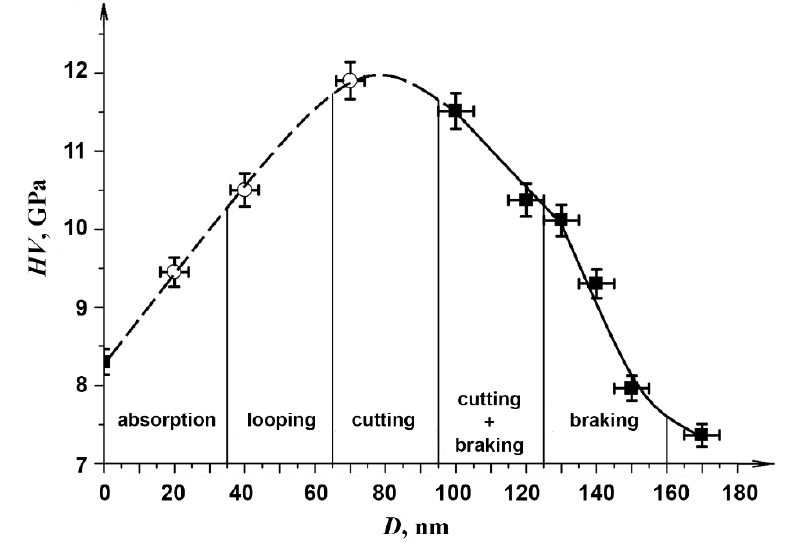
Figure 9. Microhardness of the Fe 58 Ni 25 B 17 AA as a function of the average size of nanoparticles, taking into account the implementation of priority mechanism of interaction between shear bands and nanocrystals.